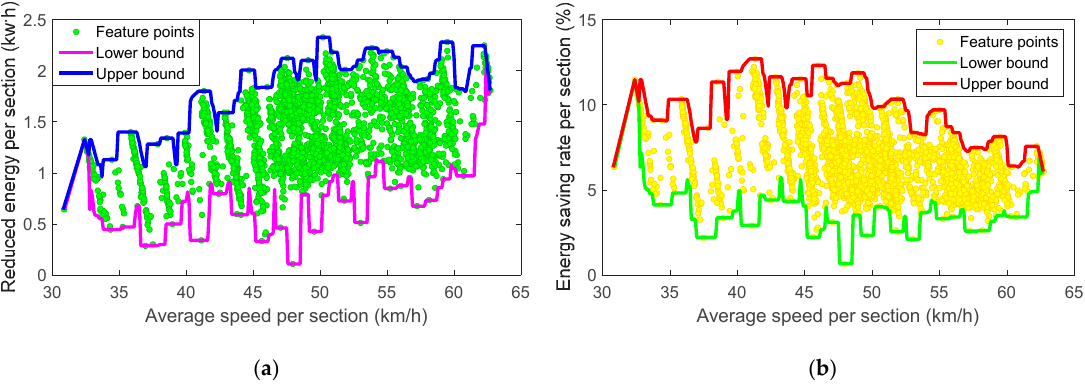
Figure 10. Boundaries of ASS-REN-PLF and ASS-RER-PLF profiles (weekday, SH-TQ, N p = 635). ( a ) ASS-REN-PLF profile result; ( b ) ASS-RER-PLF profile result.